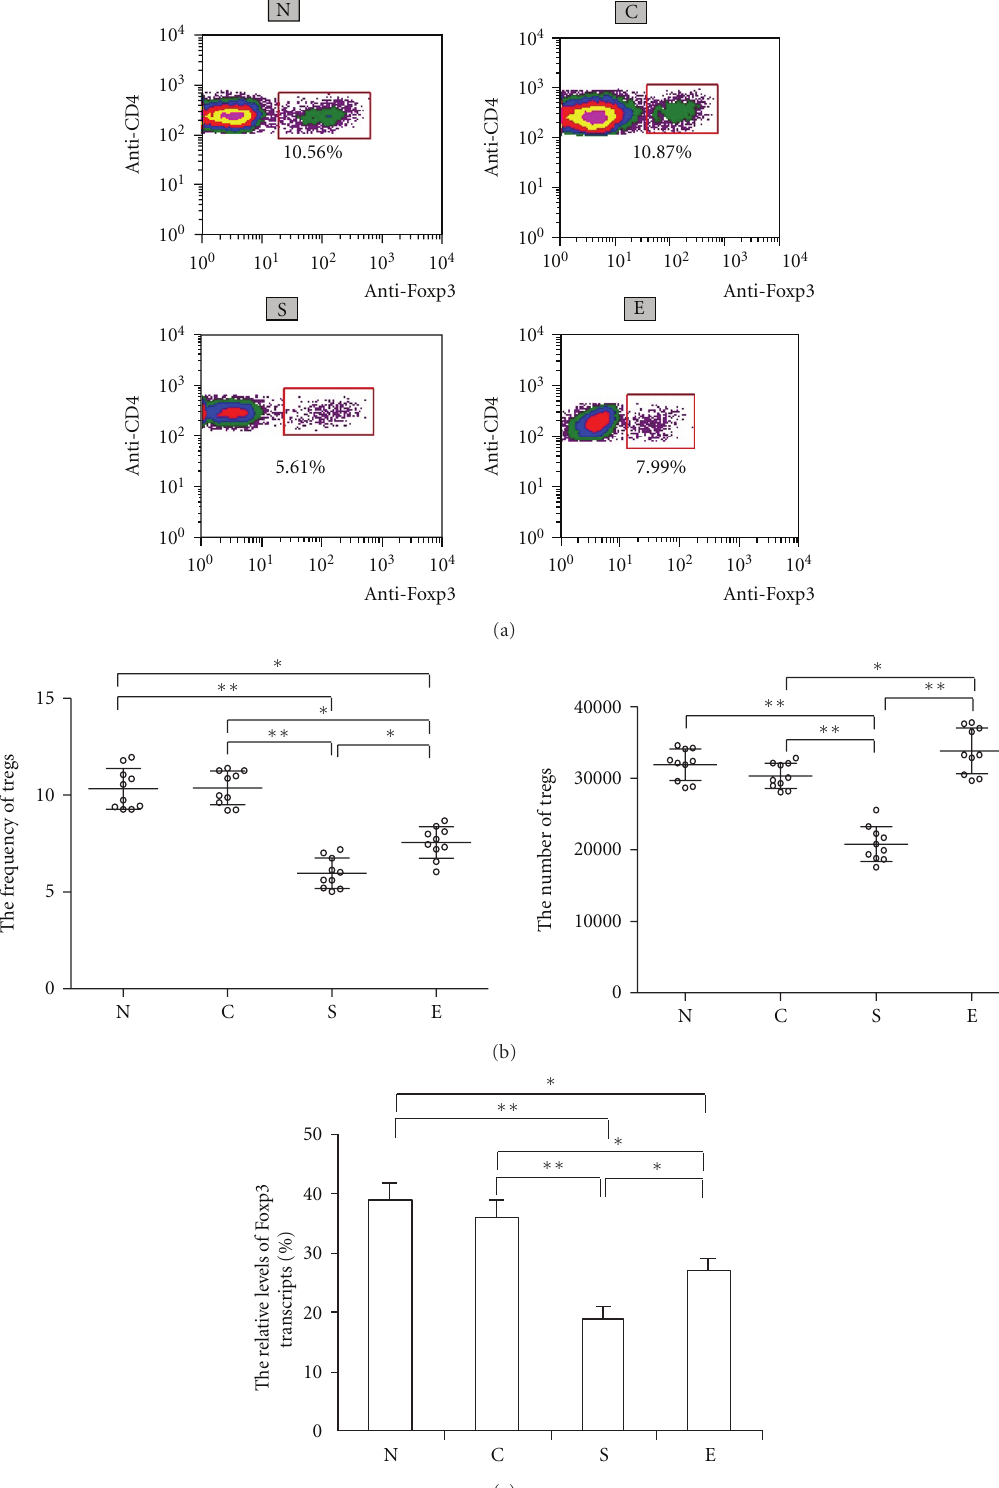
Figure 4: Treatment with erythromycin modulates the frequency and the number of Treg and Foxp3 transcription in the lungs of rats. The frequency of Tregs, the number of Tregs (b), and the relative levels of Foxp3 mRNA transcripts to β -actin in the lungs (c) were analyzed by flow cytometry (a) and RT-PCR, respectively. The isolated lung cells were stained with anti-CD4 and anti-Foxp3 and subjected to flow cyto- metry analysis. Data are expressed as mean numbers of individual samples and mean values (lines) of each group or the mean ± SD of the relative levels of Foxp3 mRNA transcripts of each group ( n = 10 per group) of rats from three separate experiments. Group N: rats exposed to regular air without any special treatment; Group C: rats exposed to regular air and were treated with erythromycin; Group S: rats exposed to smoking air and were treated with saline; and Group E: rats exposed to smoking air and were treated with erythromycin daily for nine weeks beginning at the forth weeks smoking. ∗ P < 0 . 05, ∗∗ P < 0 .